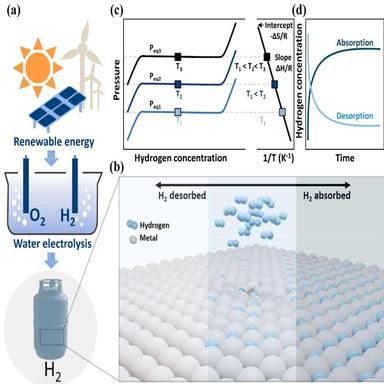
Schematics of (a) sustainable hydrogen energy systems, including hydrogen production and storage and (b) transition between hydrogen and metal when hydrogen is absorbed or desorbed. (c) Schematics of (left) PCT curves for three temperatures T1 < T2 < T3 and (right) corresponding van 't Hoff plot, and (d) time evolution of hydrogen concentration for hydrogen absorption and desorption.